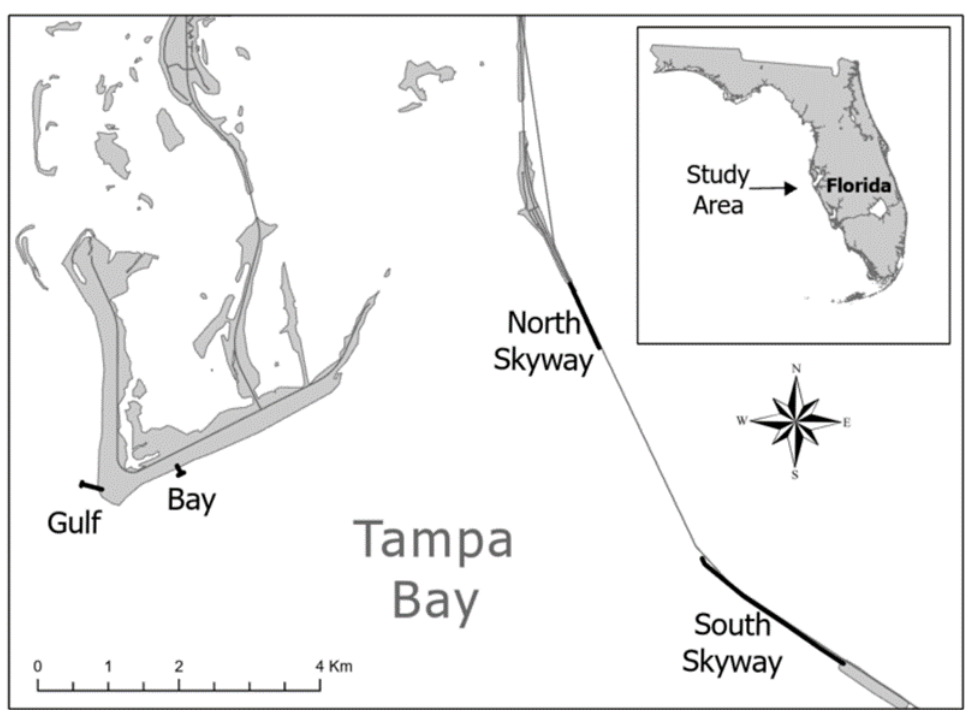
Figure 1. The four fishing piers located in the Tampa Bay region, Florida, USA. The Gulf and Bay piers are at Ft. De Soto County Park and the North and South Skyway piers are adjacent to the Sunshine Skyway Bridge.